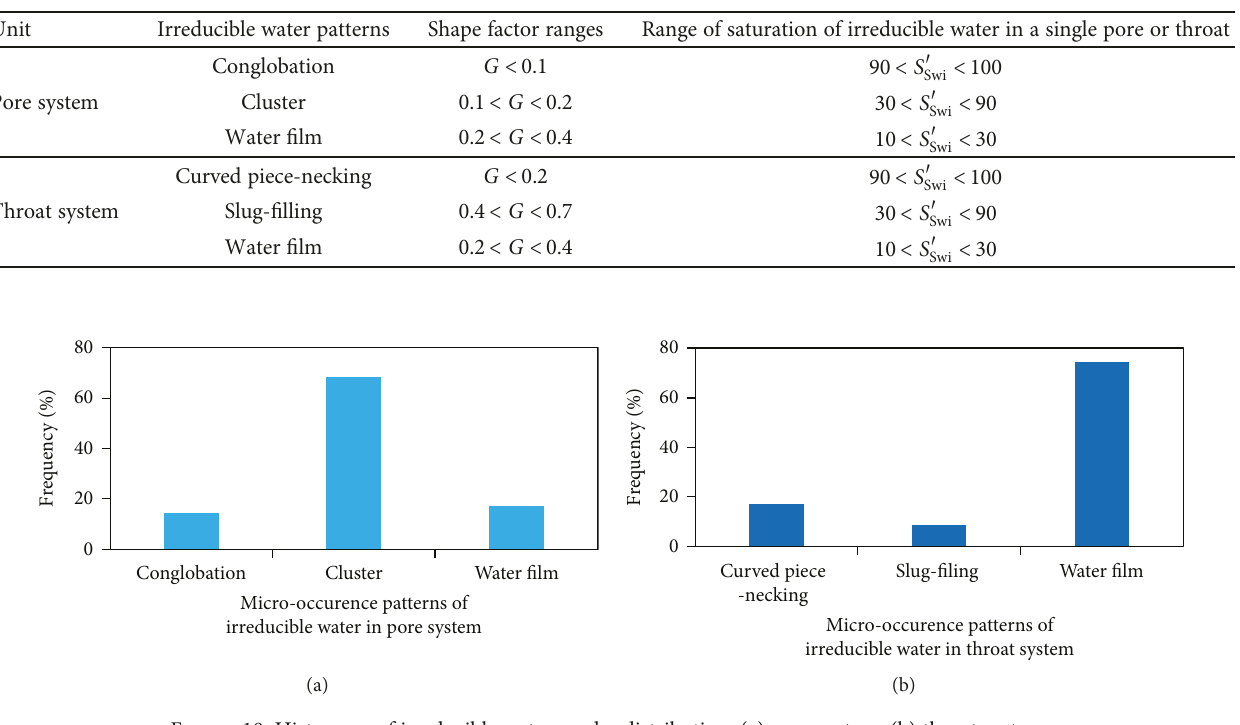
Table 3: Classi fi cation of microcharacteristics of irreducible water in the pore and throat system.